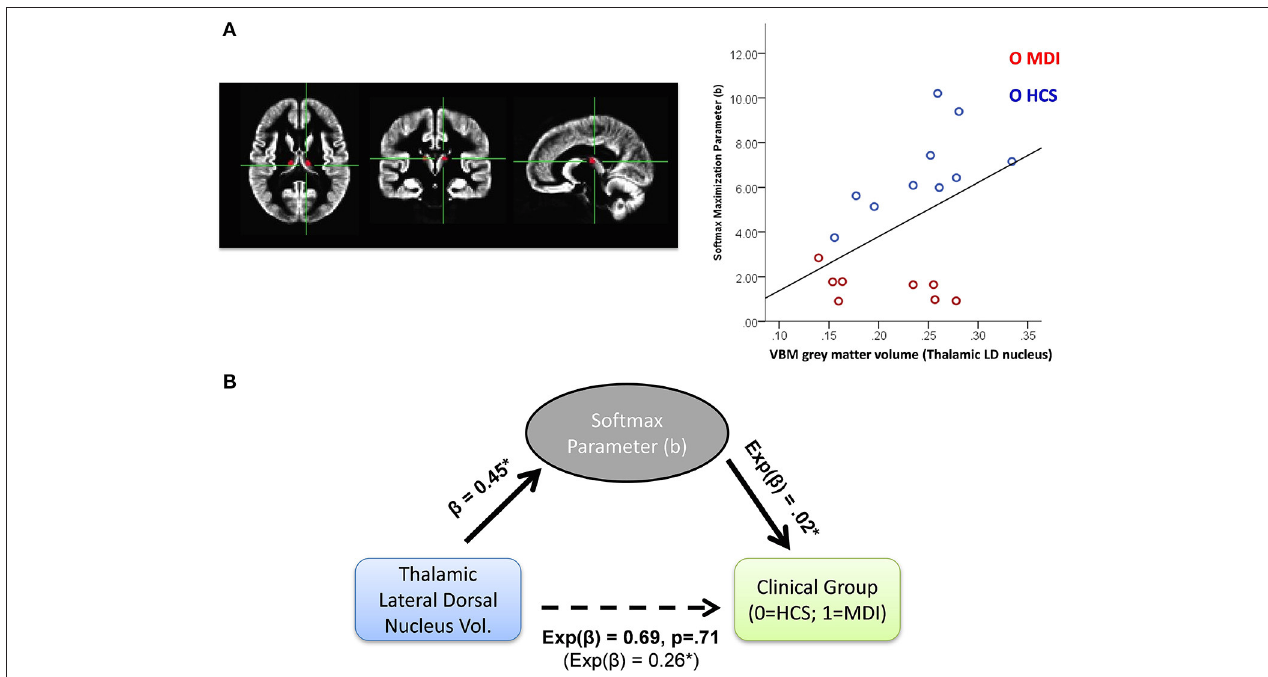
FIGURE 5 | (A) Left panel: thalamic lateral dorsal nucleus (LD) ROI in axial, coronal, and sagittal planes; Right: correlation between Softmax b paramter and VBM based gray matter volume in the thalamic LD in Softmax users ( N = 17 ). (B) Mediation analysis with hierarchical generalized linear models (with a logit link function for models predicting clinical group). Softmax b parameter was found to fully mediate the negative relationship between thalamic LD gray matter volume and likelihood to be MDI vs. HCS (MDI, methamphetamine dependent individuals; HCS, healthy comparison subjects); * p < 0.05